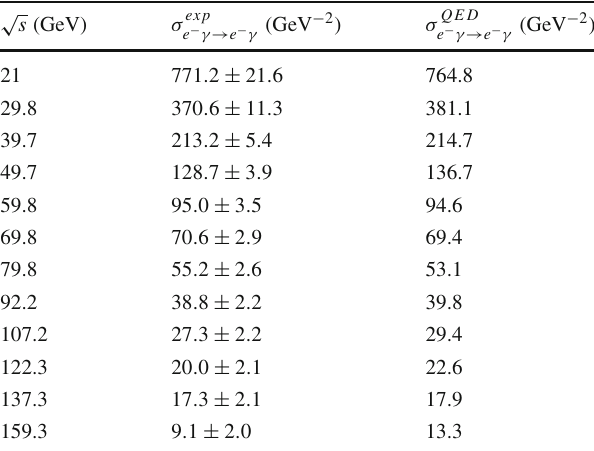
Table 1 Experimental values and SM prediction of the cross section for Compton scattering taking from [136] √ s (GeV)